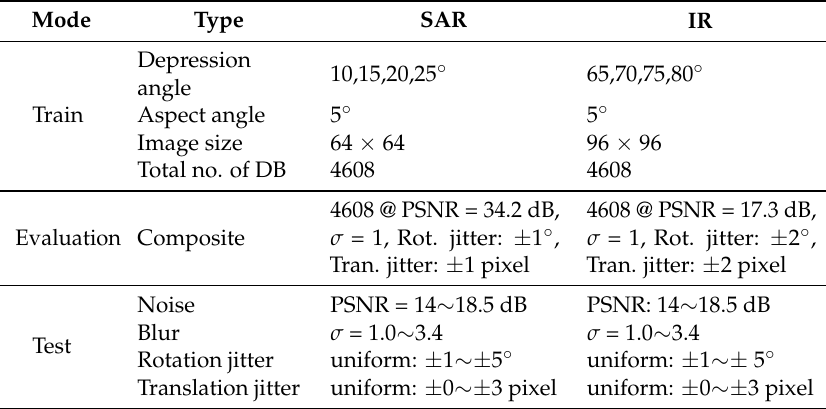
Figure 11. Composition of the SAR-IR target database: ( a ) 16 SAR targets ( top ) and 72 aspect views of T72 at the depression angle 20 ◦ ( bottom ); ( b ) corresponding 16 IR targets ( top ) and 72 aspect views of T72 at the depression angle 75 ◦ ( bottom ). Table 2. Composition of the train, evaluation, and test SAR-IR